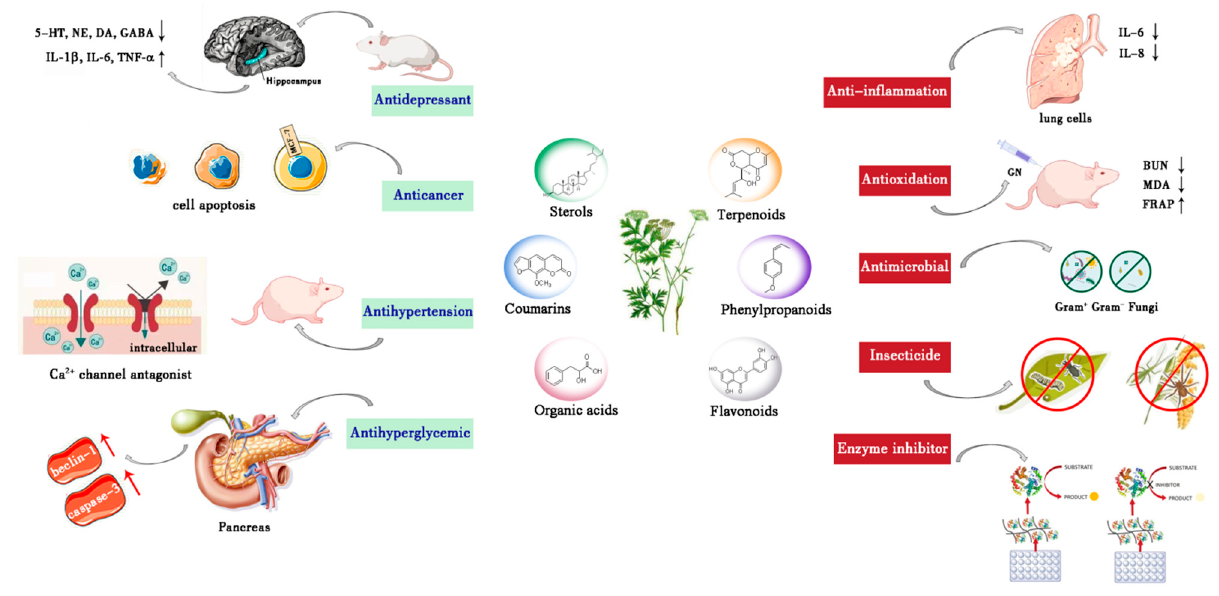
Figure 9. The pharmacological mechanisms of the genus Pimpinella .